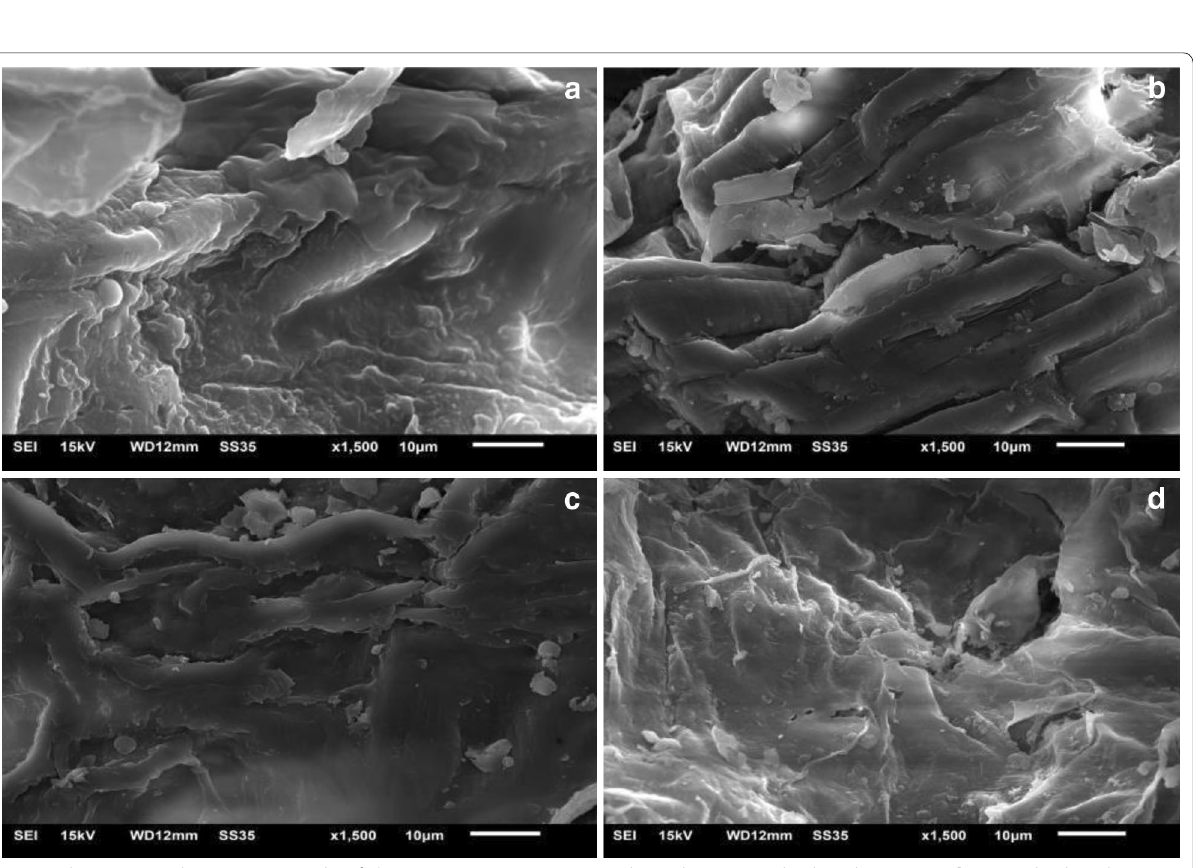
Figure 5 showed the characteristic shape of the CD signal of the original pectinase, aqueous solution pec- tinase, and pectinase treated with ionic liquids which reflect the change of the secondary structure of the protein. Compared with the original pectinase, the sample treated with aqueous solution and the sample treated with ionic liquids had varying degrees of change on characteristic shape, which may cause changes of